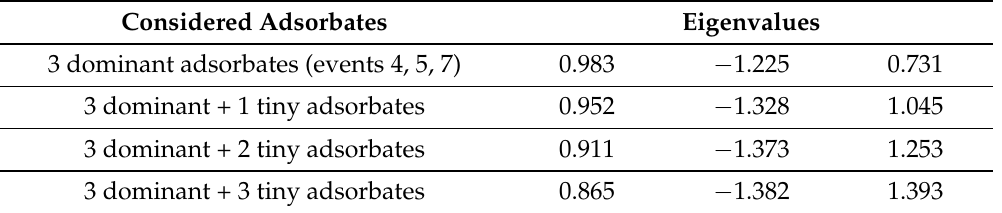
Table 1. Variation of eigenvalues in a function of diversity of adsorbates.